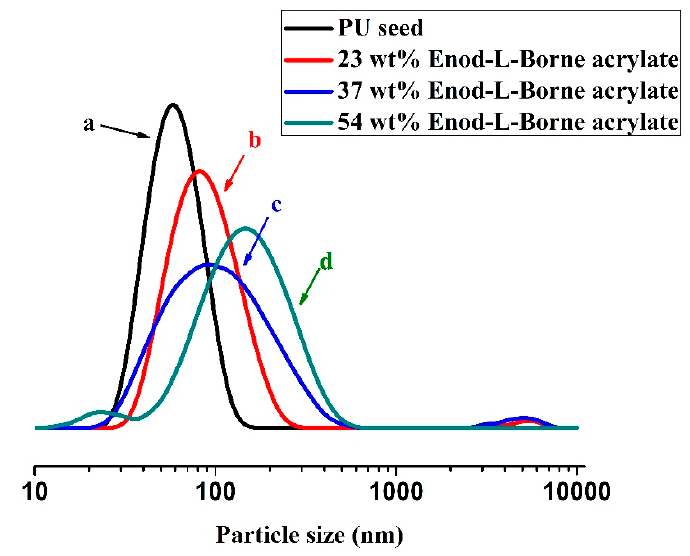
Figure 2. Size distribution curves of the core and core-shell latex particles: ( a ) PU seed; ( b ) 23 wt.% Endo-L-Borneol acrylate; ( c ) 37 wt.% Endo-L-Borneol acrylate; ( d ) 54 wt.% Endo-L-Borneol acrylate.